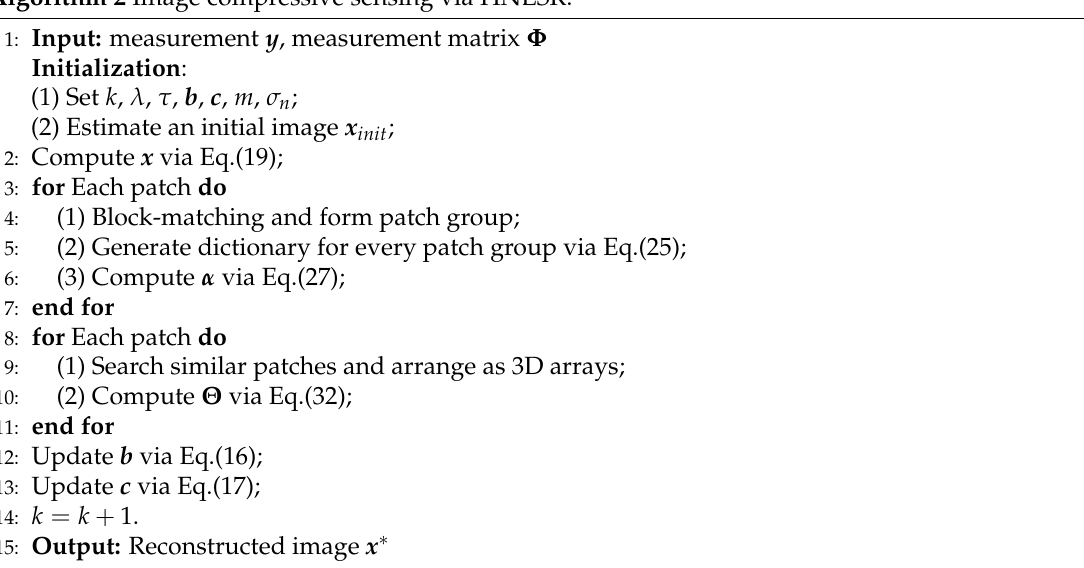
Algorithm 2 Image compressive sensing via